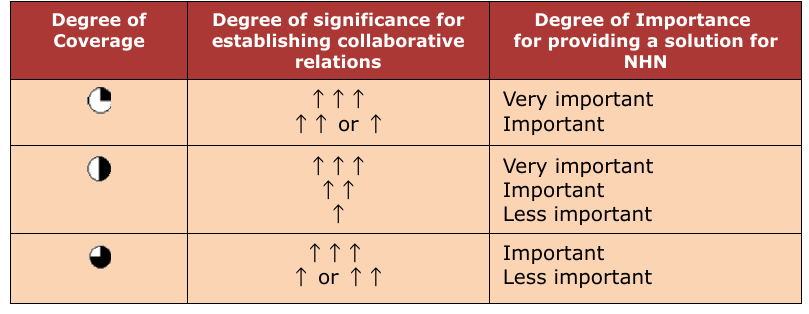
Table 4. Allocation rule for determining the